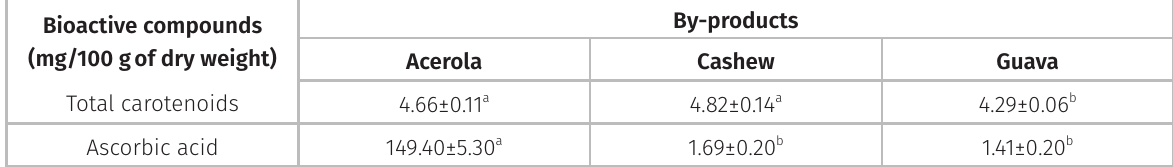
Table I. Total carotenoids and ascorbic acid contents in acerola, cashew and guava processing by-products. Bioactive